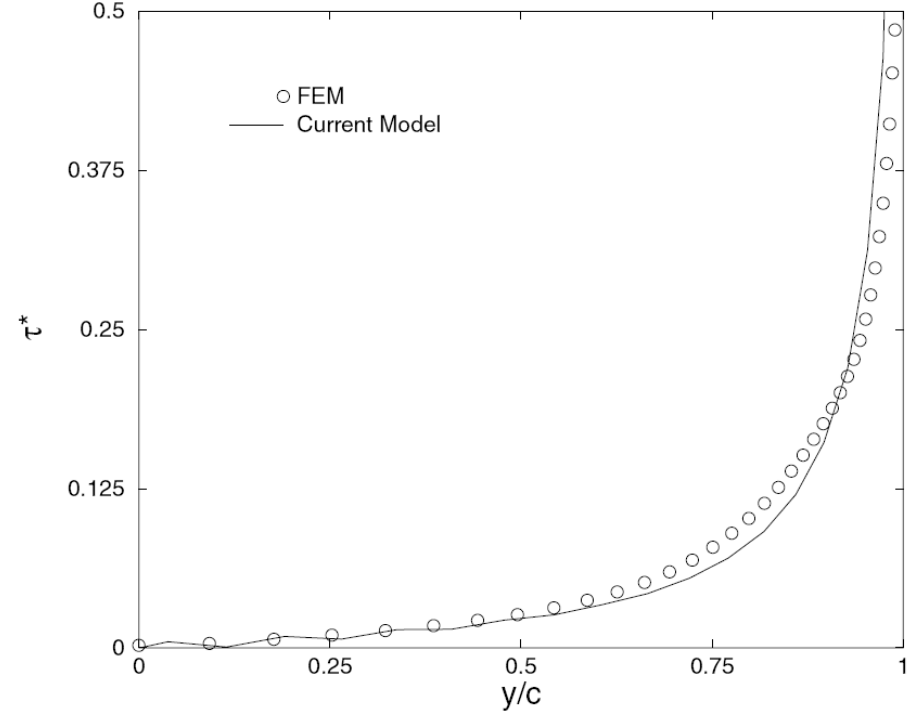
Figure 5. The normalized interfacial shear stress. Taken from Wang and Huang [50].